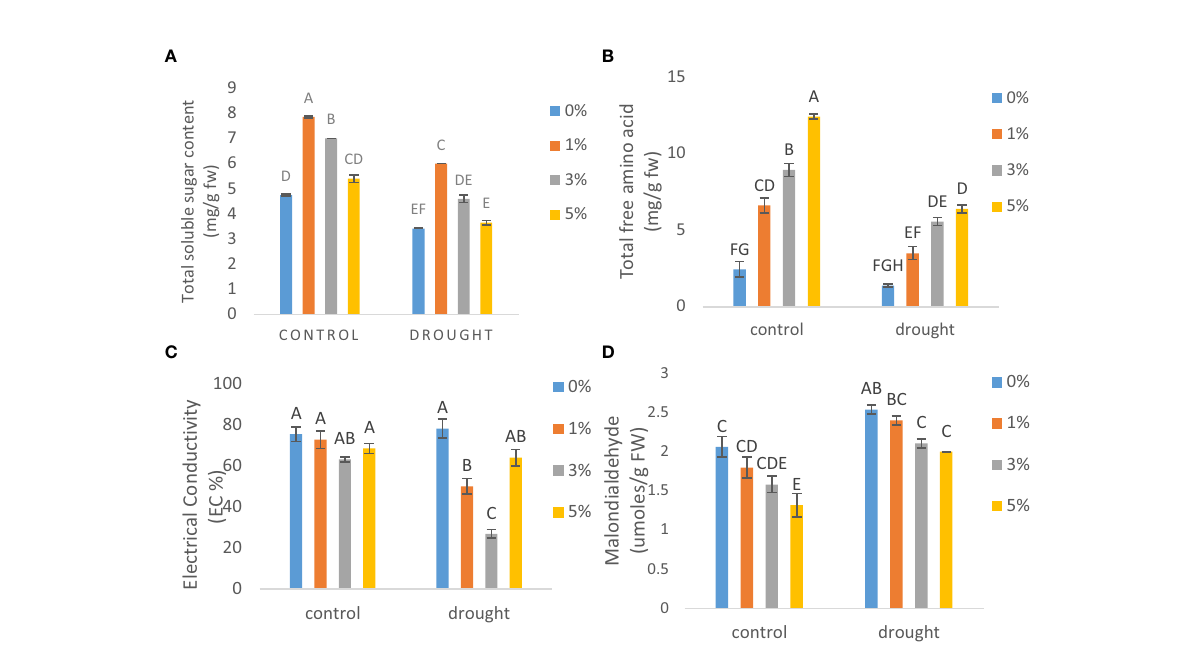
FIGURE 3 The effect of different concentrations of foliar application of nanonutrient solution on (A) total soluble sugars, (B) total free amino acids, (C) electrolyte leakage and (D) malondialdehyde in leaves of tomato (Solanum lycopersicum) under drought. Mean values are the average of three replicates. The upper case alphabetic letters indicate signi fi cant differences (P ≤ 0.05) among treatments using Tukey's test